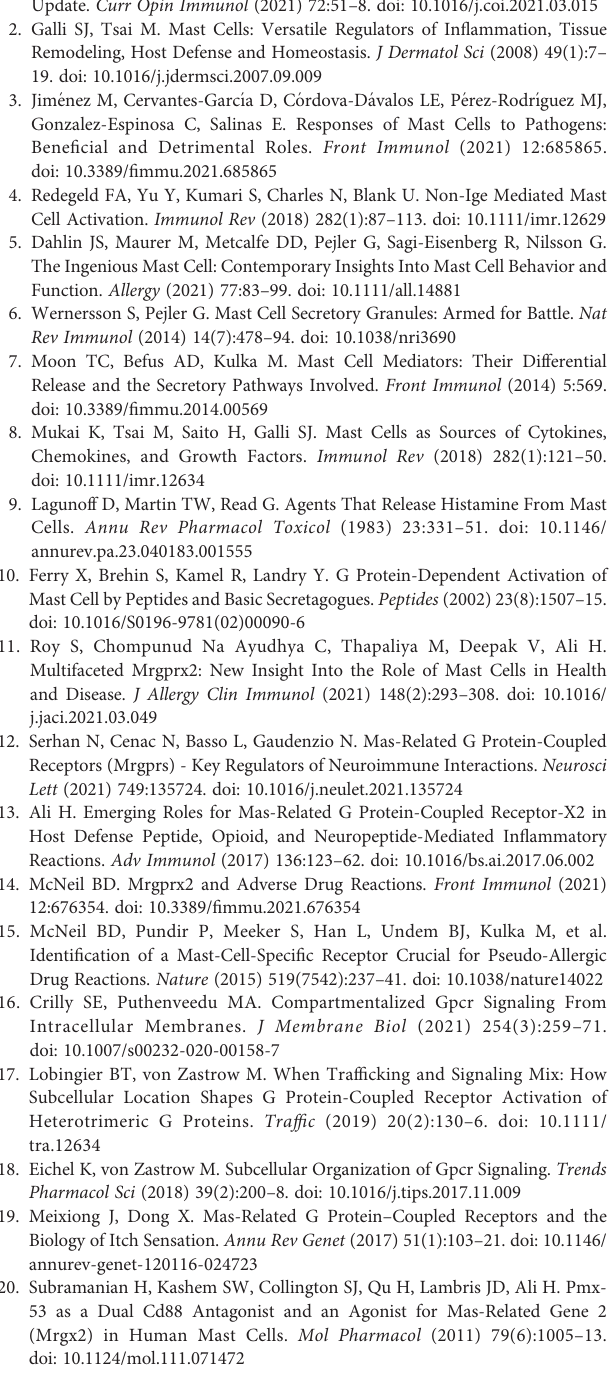
Macropinosomes are shown by the overlap with the bright fi eld (BF) image. White arrows point to MRGPRX2 that is localized to macropinosomes. Blue arrows points to STX3 located at the plasma membrane, where it overlaps with MRGPRX2. Arrowheads point to macropinosomes. Scale bars =